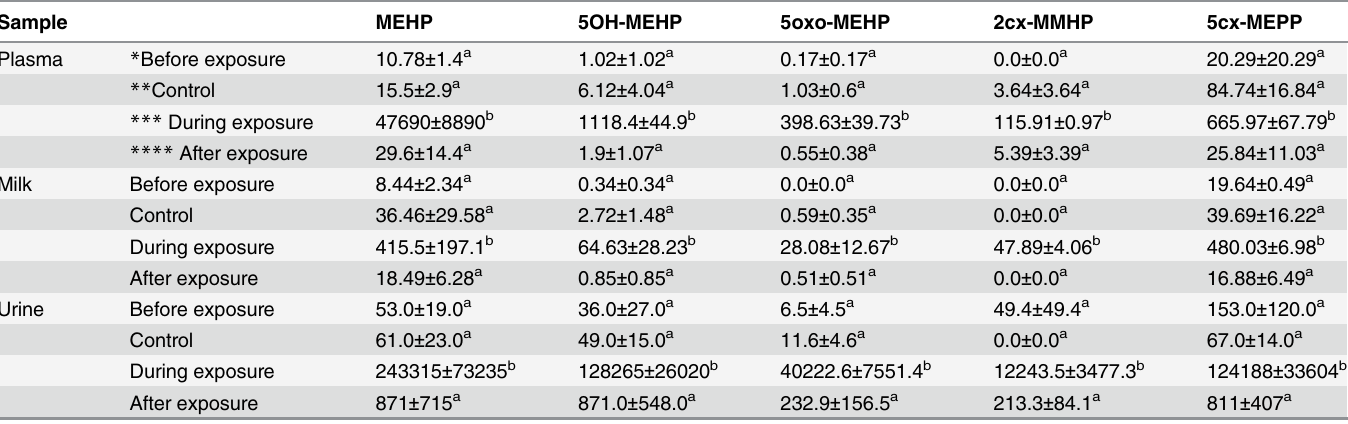
Table 2. Phthalate-metabolite concentrations (nM) in pooled plasma, milk and urine samples collected before, during and after DEHP